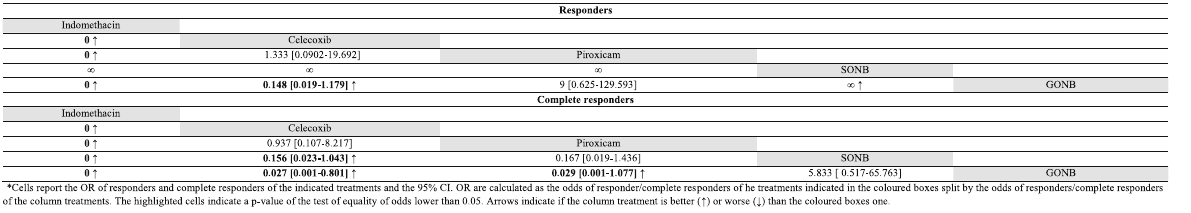
*Cells report the OR of responders and complete responders of the indicated treatments and the 95% CI. OR are calculated as the odds of responder/complete responders of he treatments indicated in the coloured boxes split by the odds of responders/complete responders of the column treatments. The highlighted cells indicate a p -value of the test of equality of odds lower than 0.05. Arrows indicate if the column treatment is better ( ↑ ) or worse ( ↓ ) than the coloured boxes'